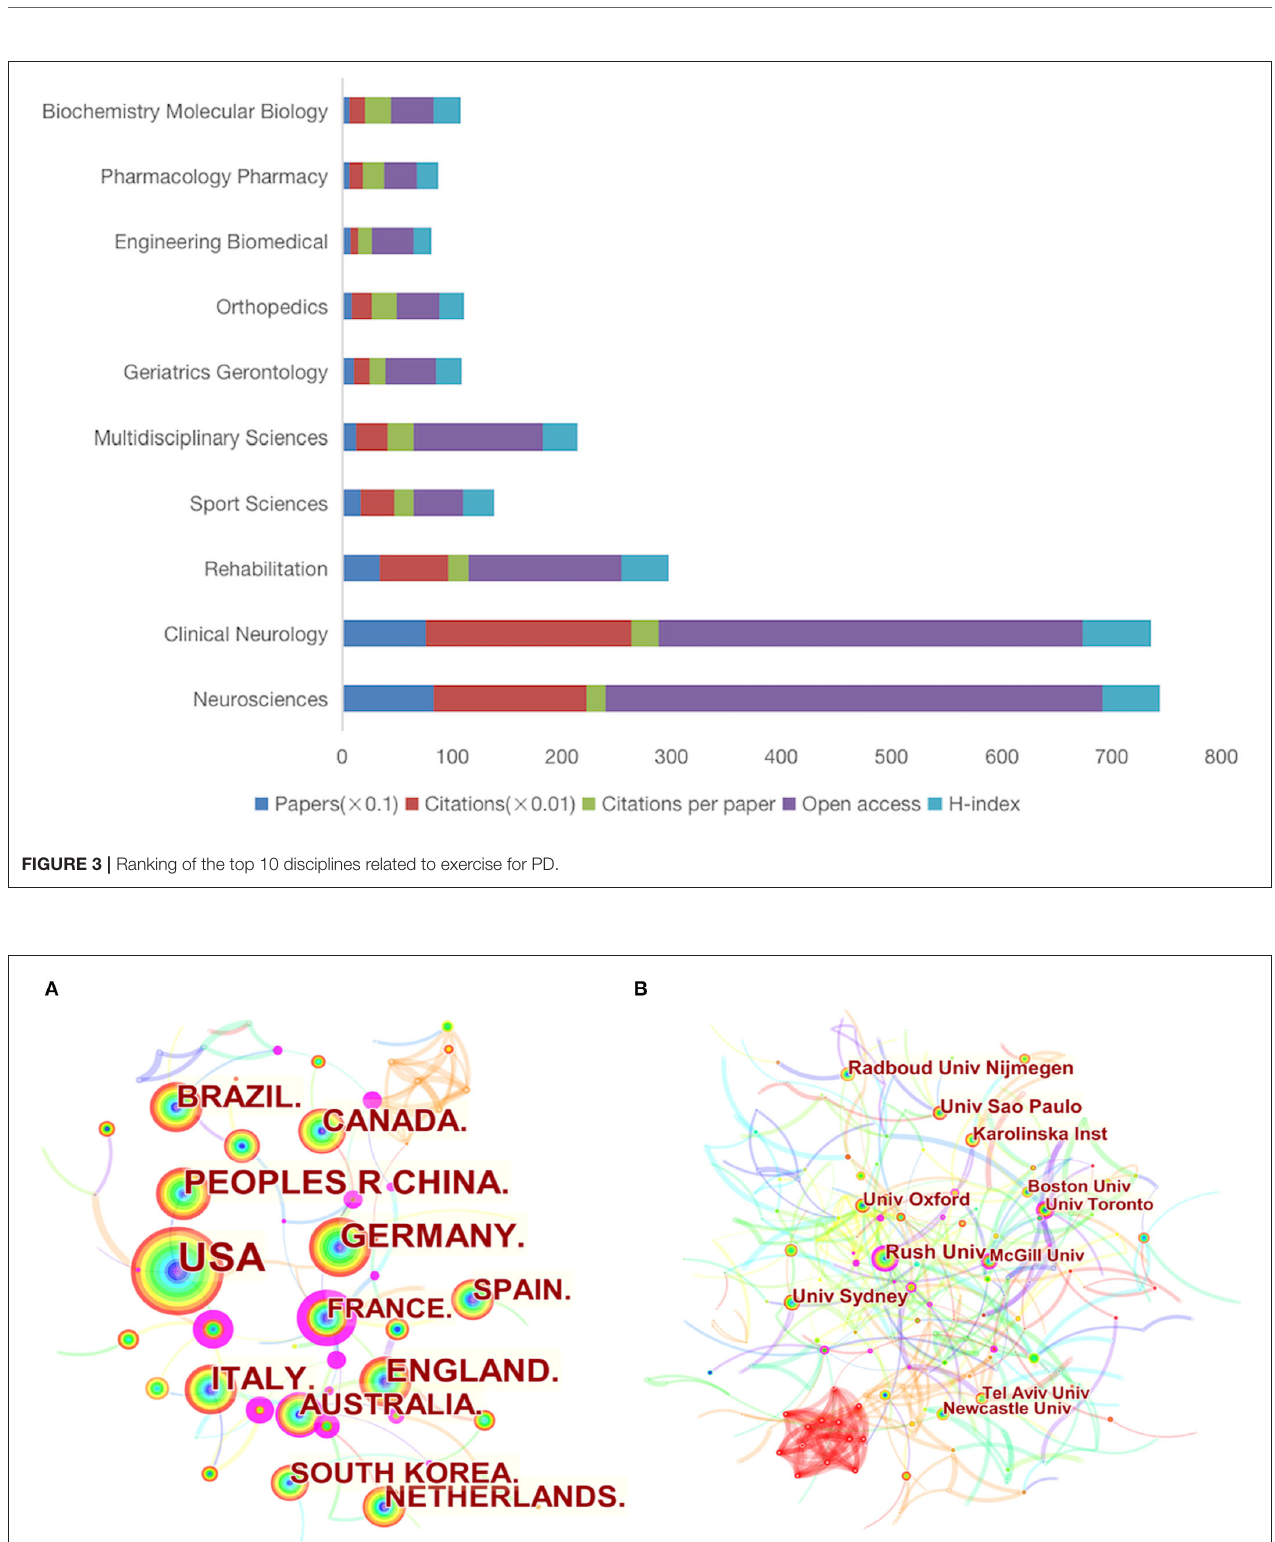
Frontiers in Human Neuroscience |